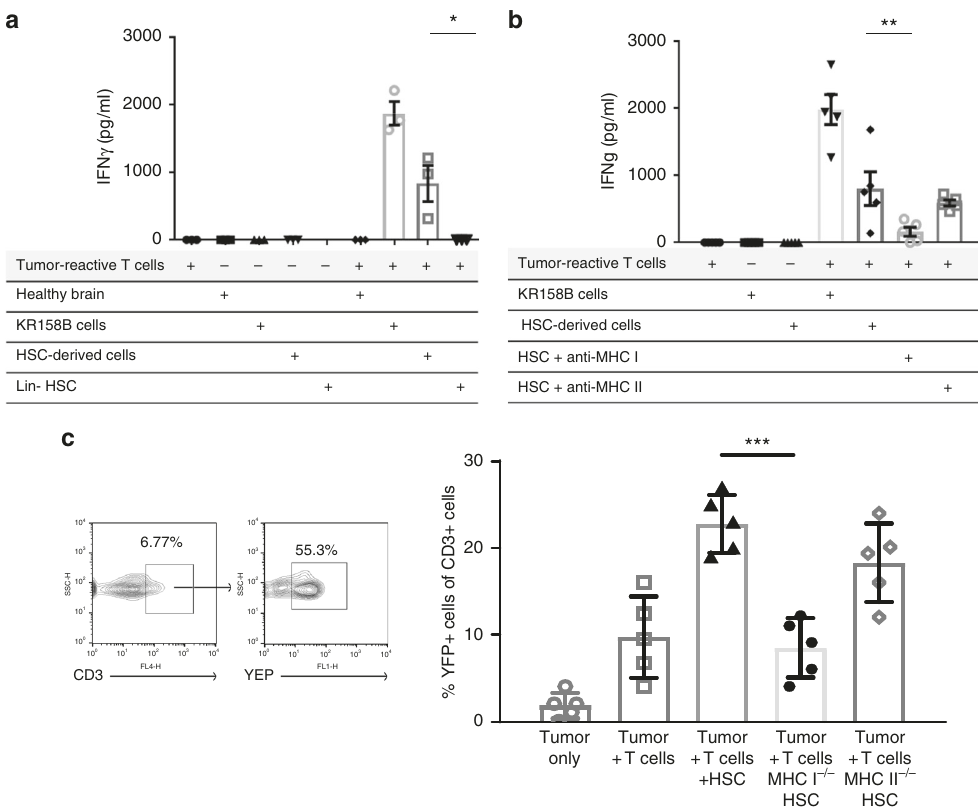
Fig. 6 HSCs cross-prime tumor-reactive T-cells via MHC I. a Glioma-bearing mice received adoptive cell therapy with concomitant transfer of GFP + HSCs. Three weeks post transfer, GFP + cells were FACS isolated from the tumor. These were then used as targets in a functionality co-culture assay for tumor- reactive T-cells, and supernatant IFN γ was measured. b In a repeat experiment, blocking antibodies for MHC I and MHC II were added to the co-culture assay and supernatant IFN γ was measured, and relative amounts between unblocked HSC-derived cell targets and when MHC-I was blocked (** p = 0.0271, t -test, n = 3 biological replicates). c Glioma-bearing mice received adoptive cell therapy with tumor-reactive T cells generated from GREAT mice followed by concomitant transfer of HSCs, HSCs from MHC I − / − , or HSCs from MHC II − / − . Tumors were excised and relative amounts of YFP + CD3